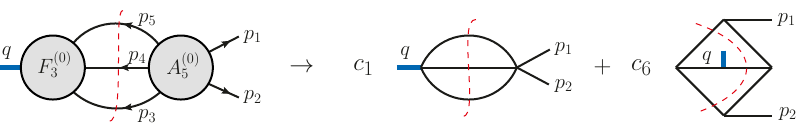
Figure 3 . The triple cut for a two-loop form factor of tr( F 2 ) with two external